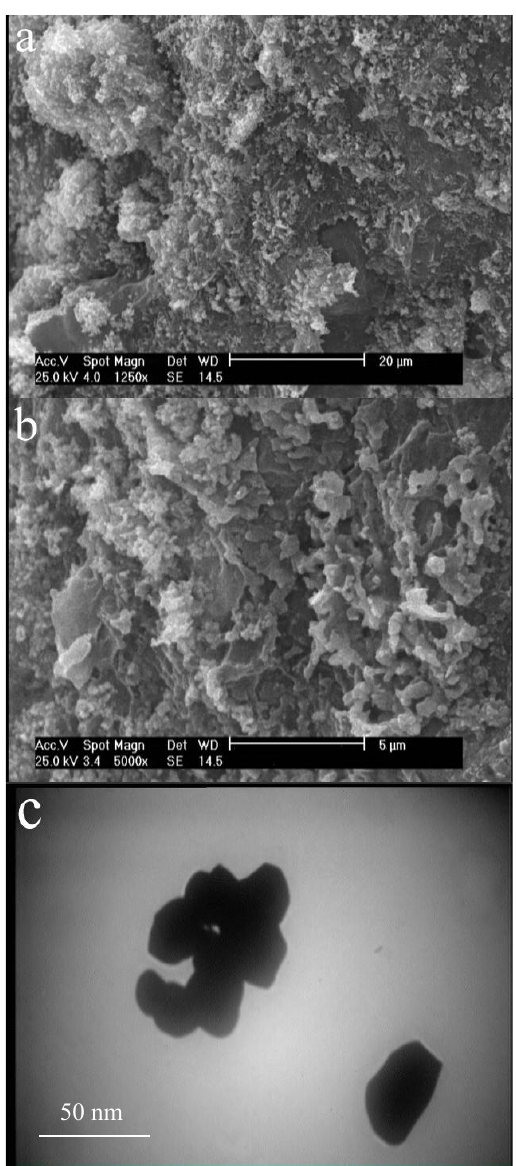
Fig. 2. (a, b) SEM and (c) TEM micrographs of the synthesize nano powder.